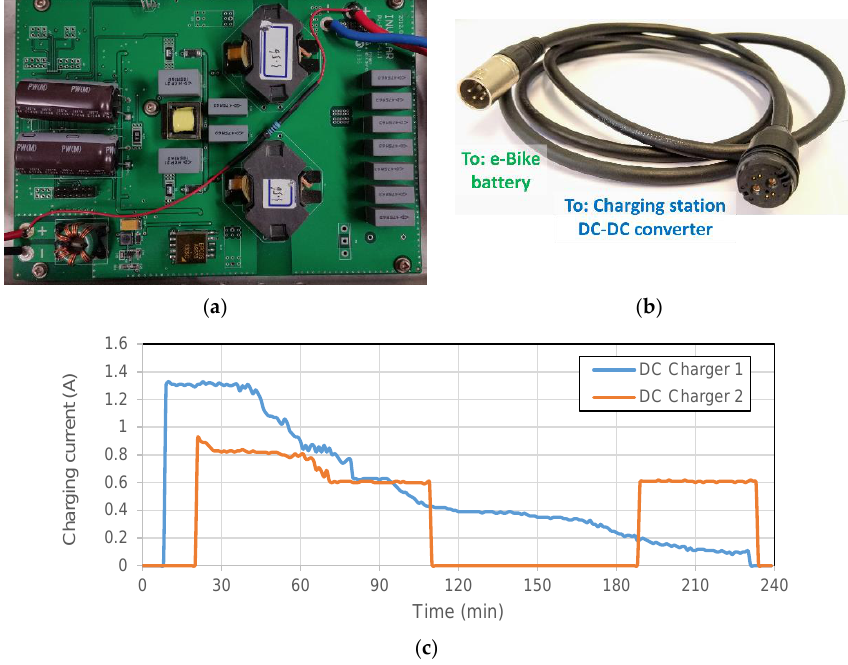
Figure 9. ( a ) Interleaved flyback converter for DC e-bike charging. ( b ) The cable used for DC charging. ( c ) Measured charging current of two e-bikes in which each is charged using the flyback based DC e-bike charger.